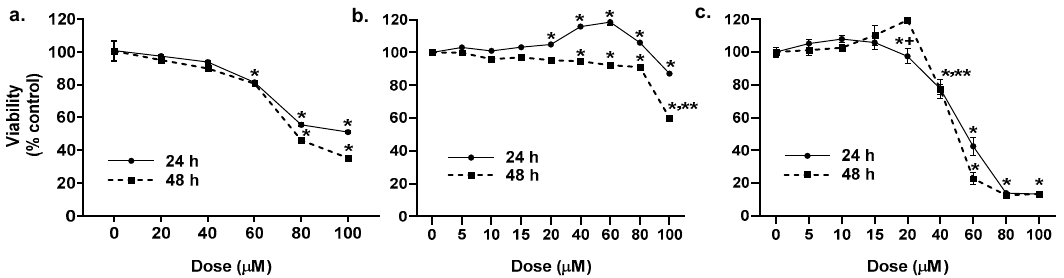
Figure 1. Cytotoxicity for epithelial (C10, E10) and macrophage (MHS) cell lines in response to LMW PAH exposure. In ( a ) C10 cells, ( b ) E10 cells, and ( c ) MHS cells for a dose response with the binary LMW PAH mixture (1:1 ratio of 1-methylanthracene and fluoranthene). Cytotoxicity was performed using an MTS assay at 24 and 48 h of treatment in cells that are serum deprived prior to treatment. For C10 and E10 cells, * p < 0.05 for treatment compared to control (DMSO); ** p < 0.05 100 µ M dose compared to 40–80 µ M dose for C10 cells. MHS cells: *, p < 0.05 treatments compared to control. + p < 0.05 20 µ M compared to 40 µ M; ** p < 0.05 40 µ M compared to all other doses.